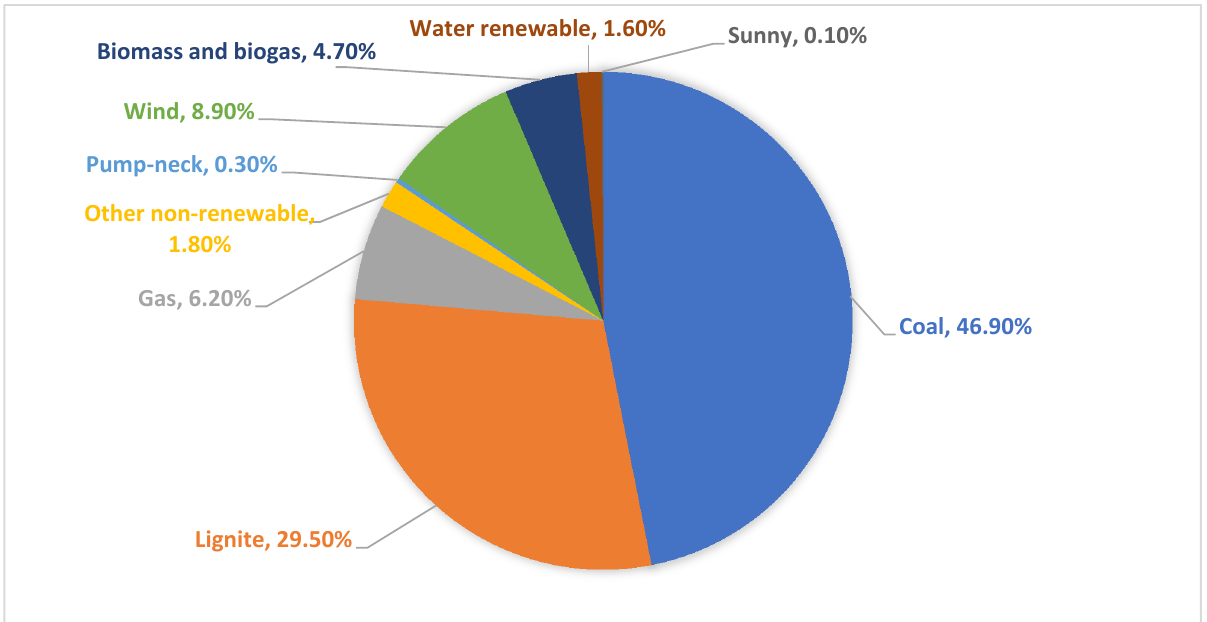
Figure 3. Structure of electricity production in Poland in 2017 [30,31].